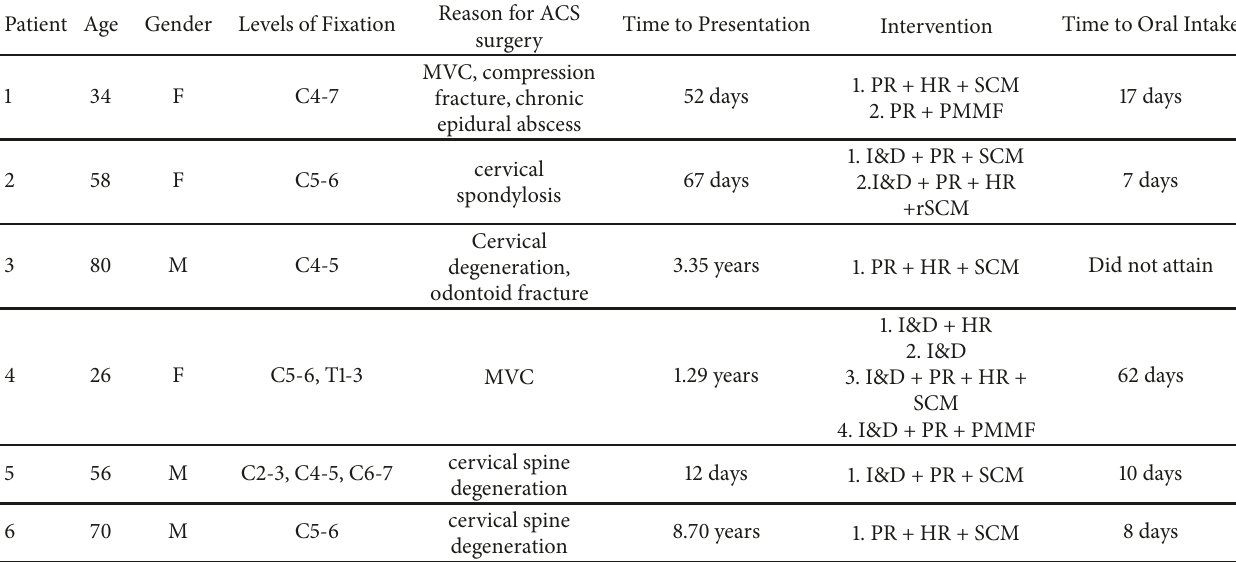
Table 1: Summary of patient data. Patient #5 had fixation at multiple levels. ACS = anterior cervical spine. MVC = motor vehicle collision. Time to presentation refers to interval since most recent ACS surgery. PR = primary defect repair. I&D = incision and drainage of abscess.